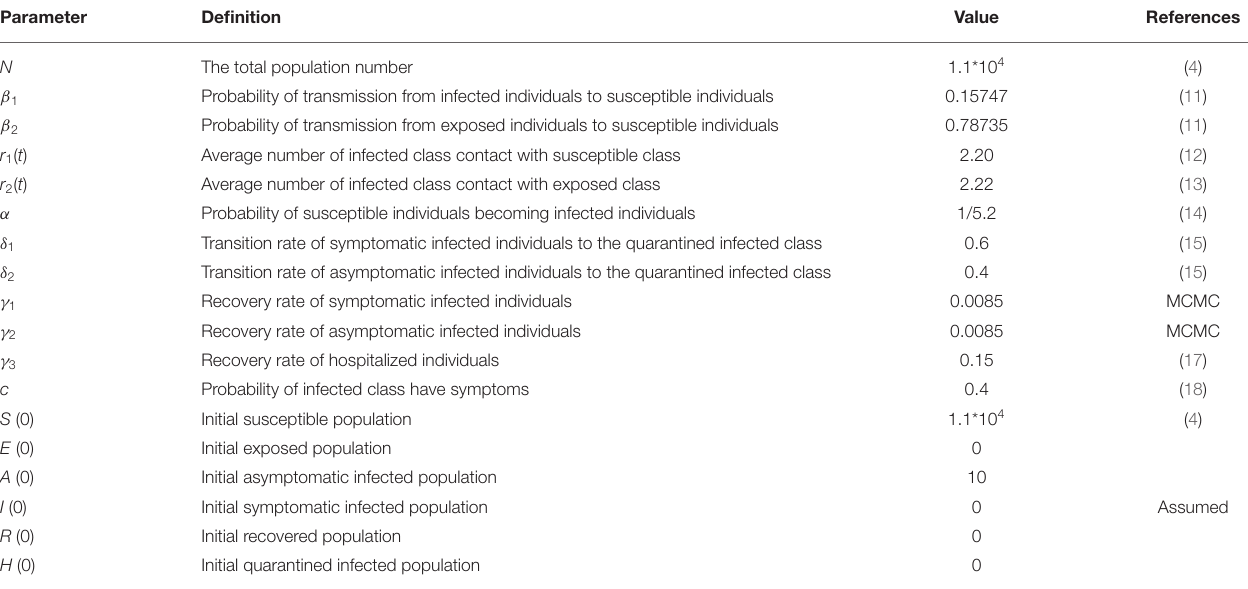
TABLE 1 | Parameter definition and